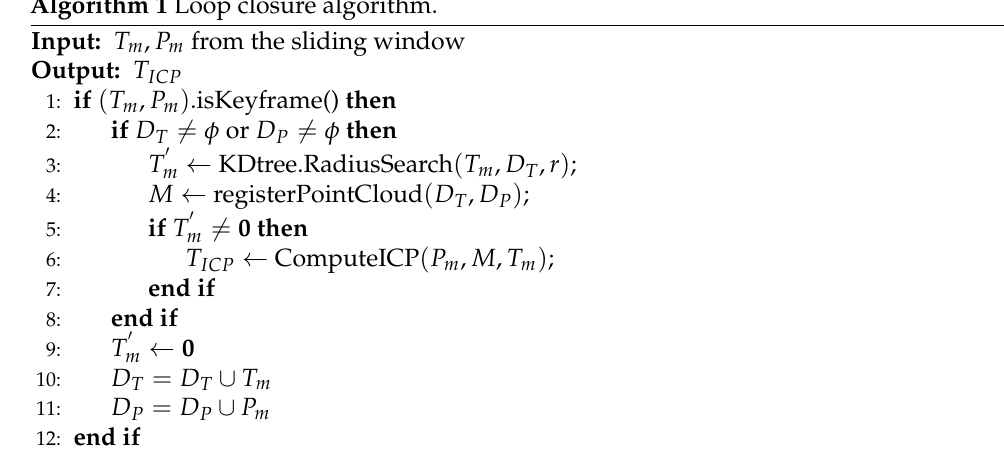
Algorithm 1 Loop closure